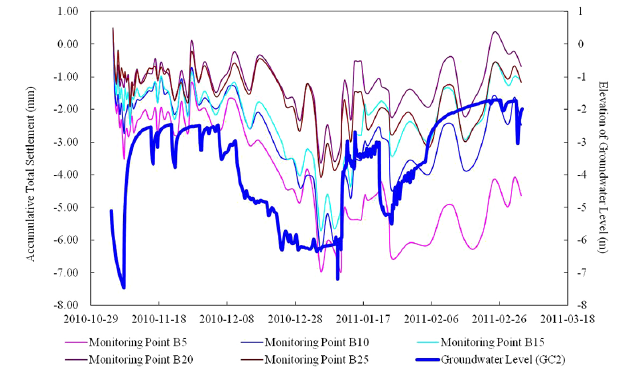
Figure 7. Duration graphical chart of pore water pressure at the point of 3 times the depth of foundation